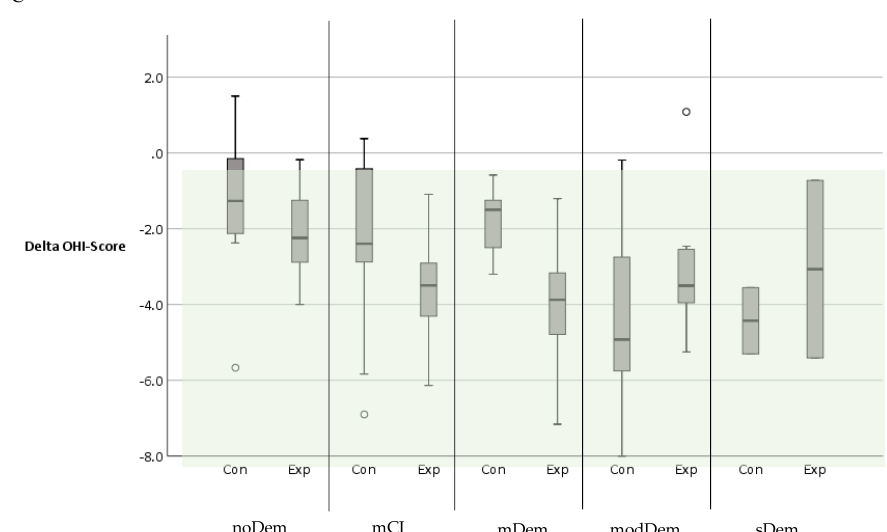
Figure 5. Changes in the oral hygiene index (OHI) and its components (DI: debris index; CI: calculus index) over time as: ( A ) ∆ OHI Plaque; ( B ) ∆ OHI Calculus; and ( C ) ∆ OHI Score separated by mini mental state examination (MMSE) group and subgroup (control/experimental group) (Con: control group; Exp: experimental group) (MMSE group—noDem: no dementia; mCI: mild cognitive impairment; mDem: mild dementia; modDem: moderate dementia; sDem: severe dementia) (color coding—green: improvement in score; circle correspond to statistical